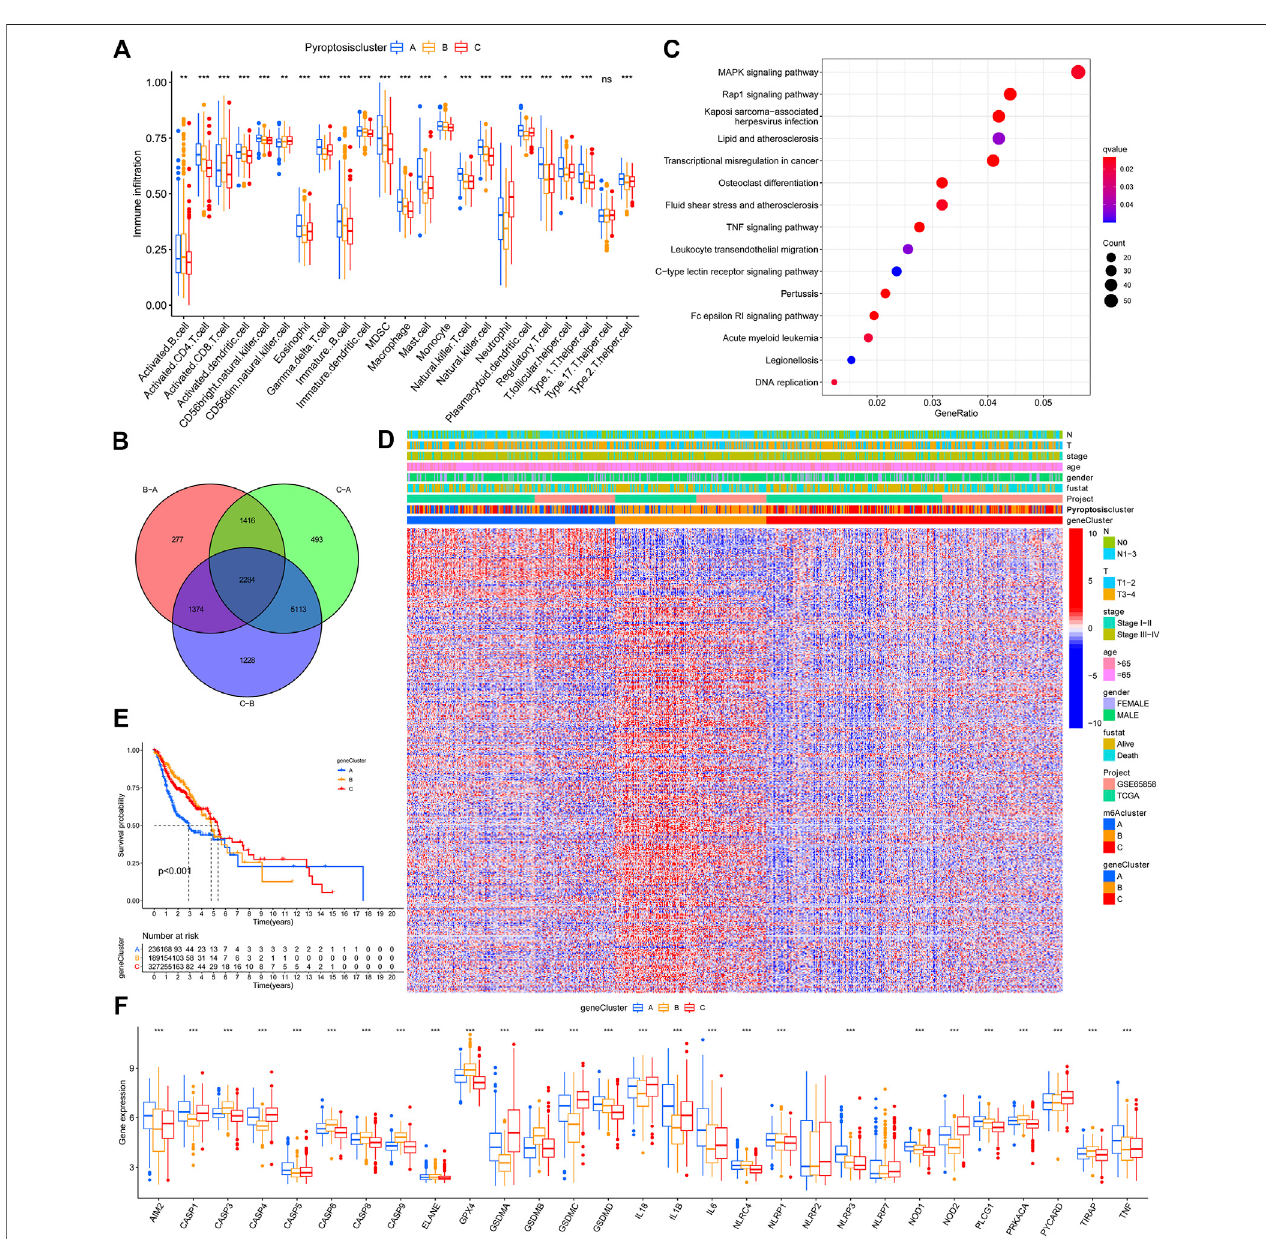
FIGURE3| TMEcellin fi ltrationcharacteristicsandfunctionalannotation. (A) .ContrastelementdifferencesofimmunecellsbetweentheclustersA,B,andCbased onthessGSEA. (B) .Venndiagramtoidentifytheco-expressedgenes. (C) .KEGGresultsbasedontheidenti fi ed2284genes. (D) .Heatmapfortheassociationbetween GeneClusters and clinicopathological manifestations. (E) . Gene cluster C demonstrated the outcome of poorer prognosis. (F) . Expression of PRGs between clusters A, B, and (C) .